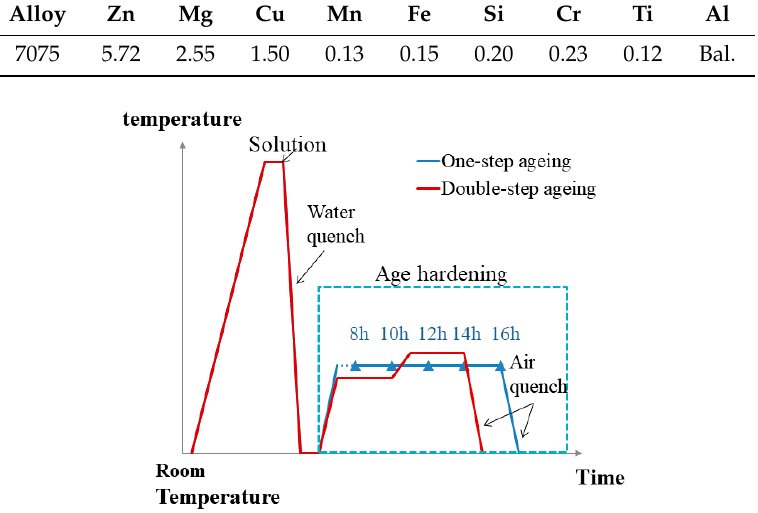
Figure 1. Schematic of the heat treatment process for 7075 Al sheets. Blue curves indicate the one-step aging process at 140 °C for 8, 10, 12, 14, and 16 h. Red curve denotes the double aging (DA) treatment at 120 °C for 3 h, followed by heating at 160 °C for 3 h.